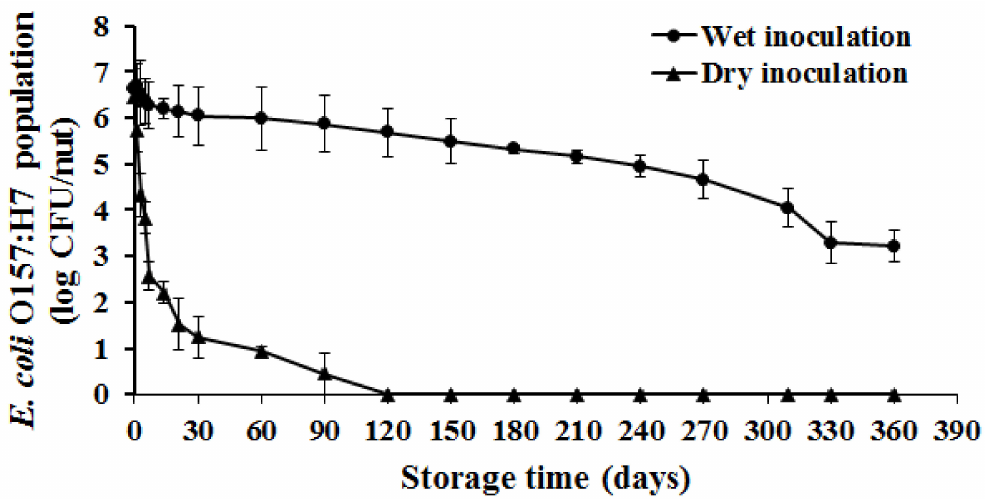
Figure 1. Survival of E. coli O157:H7 on in-shell hazelnuts. In-shell hazel nuts were inoculated with approximately 7.7 log CFU of the pathogen/nut by dipping or using a sand carrier. Following inoculation, the nuts were dried for 24 h and stored under ambient conditions for one year. At designated times during the storage, nuts were sampled to enumerate the surviving E. coli O157 populations. Data are represented as the mean ± standarad deviation of